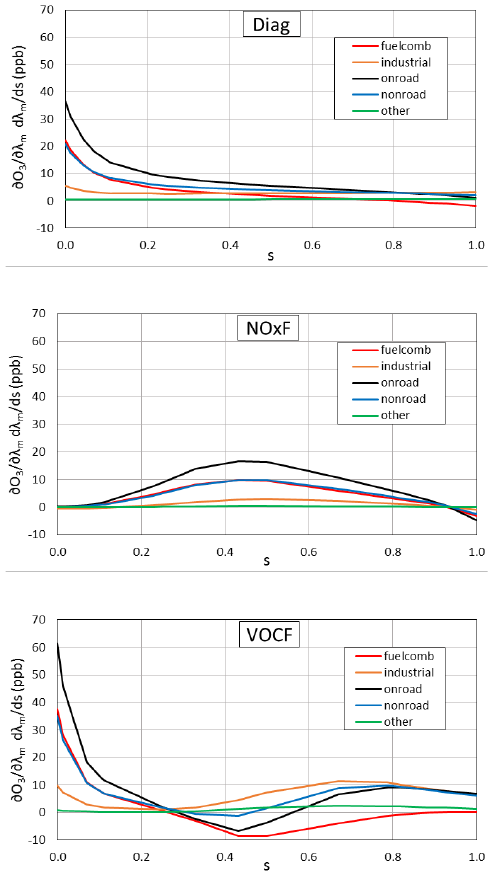
Figure 3. Dependence of the integrands for allocating O 3 to sources on the distance s along the Diag, NOxF and VOCF paths. The inte- grand (Eq. 4) is calculated at the time of peak O 3 on day 3 (66h).